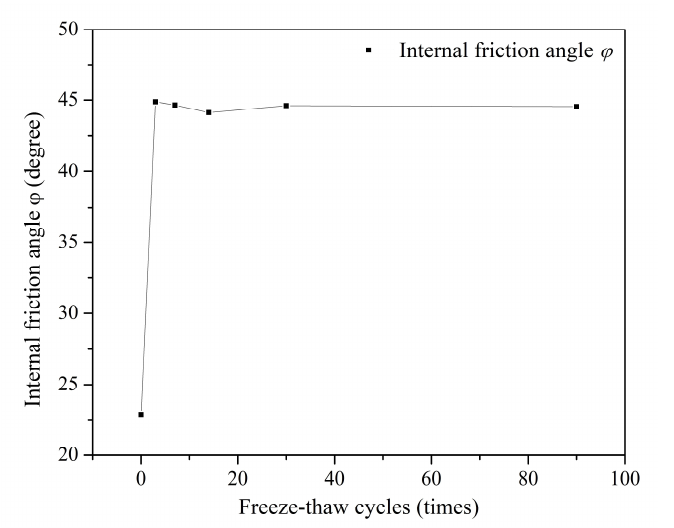
Figure 7. Variation of internal friction angle, ϕ , S/S lead-zinc-cadmium composite HM-contaminated soil with F-T cycles.